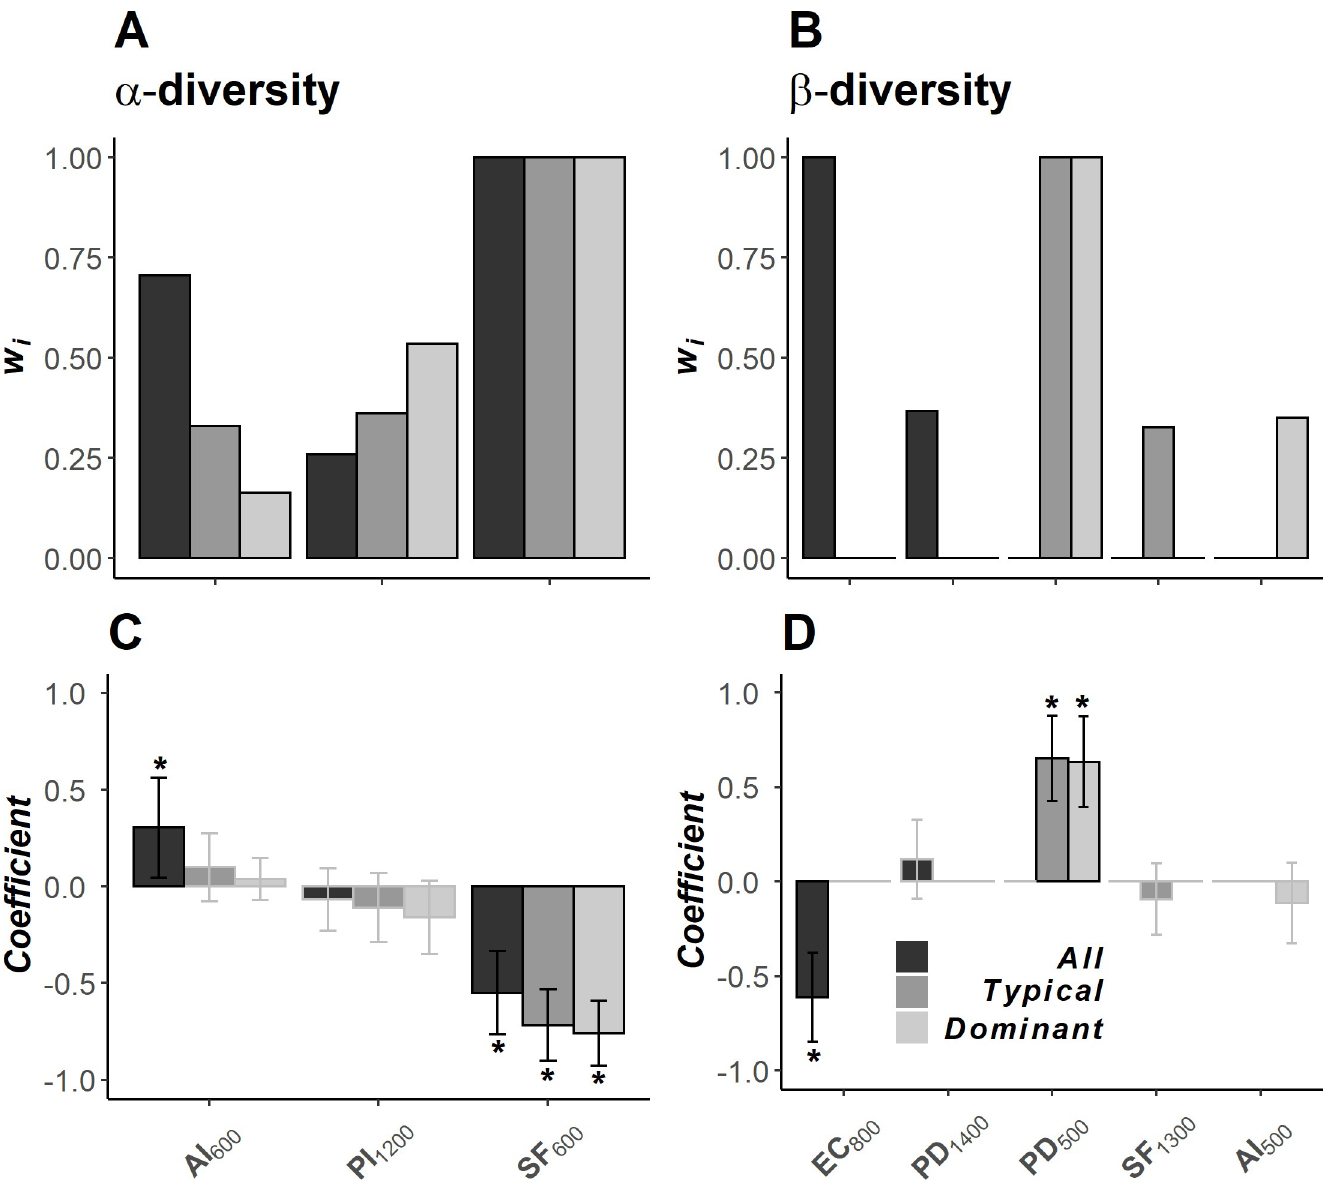
Fig 3. Importance and relative effects of the landscape metrics on seedling diversity within forest patches in a fragmented tropical rainforest in southern Mexico. We included the 95% confidence set of models for (A and C) α - and (B and D) β -diversity. The importance of each variable is represented by the sum of the Akaike weights ( ∑ w i ). The effects of each covariate were estimated through a model-averaged parameter estimate of information-theoretic-based model selection and multimodel inference. The whiskers represent the unconditional standard error (USE) and the asterisks indicate the influential variables (those for which the USE did not include zero). The landscape metrics are the aggregation index (AI), the edge contrast index (EC), the patch density (PD), patch isolation (PI), and the percentage of secondary forest (SF). The subscript numbers indicate the scale of effect of each variable.